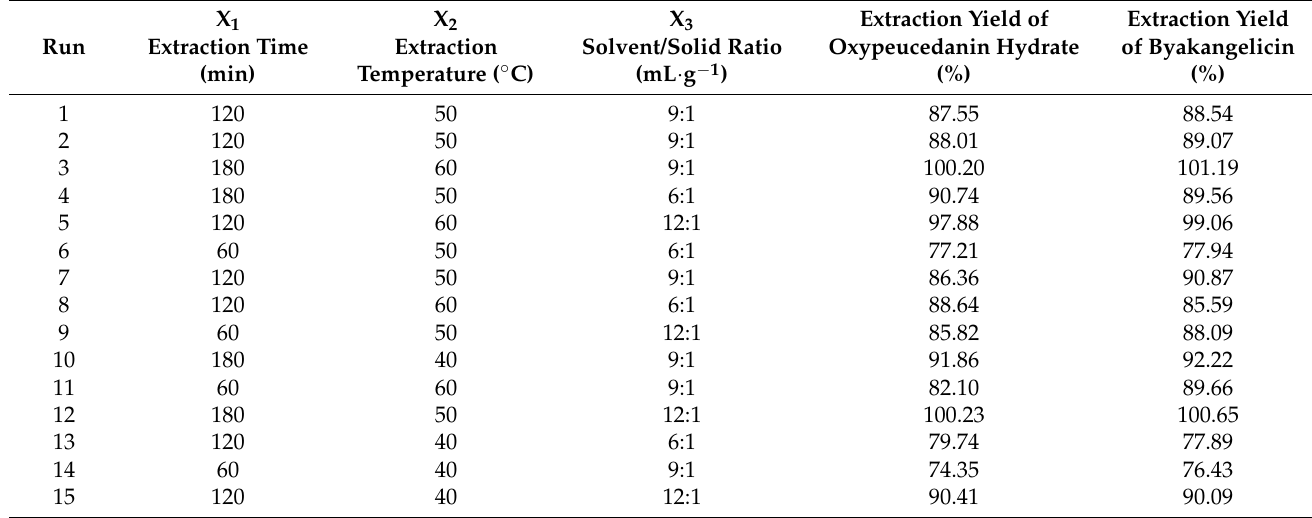
Table 2. Box–Behnken design and response values for optimization of oxypeucedanin hydrate and byakangelicin extraction.